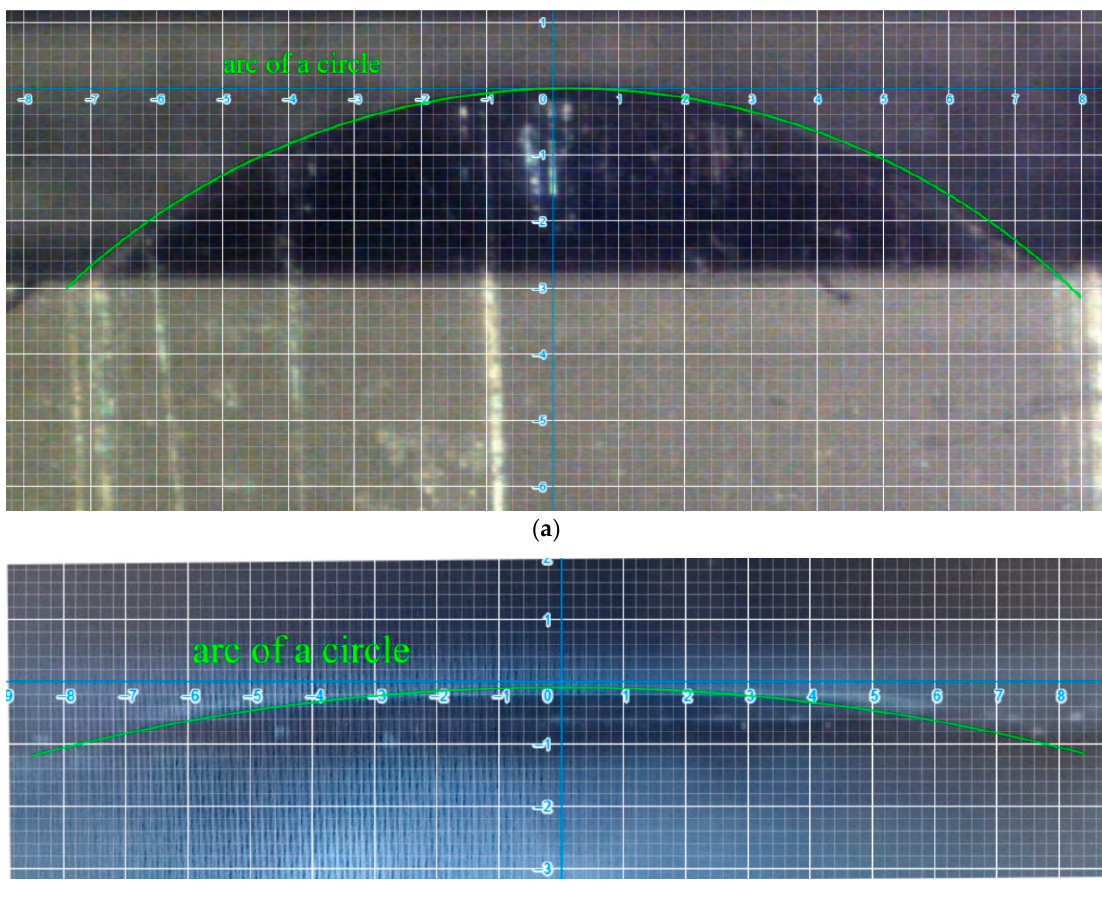
Figure 8. Cross section observed on microscope with scale grid on eyepiece. ( a ) R = 1 mm. ( b ) R = 4 mm.